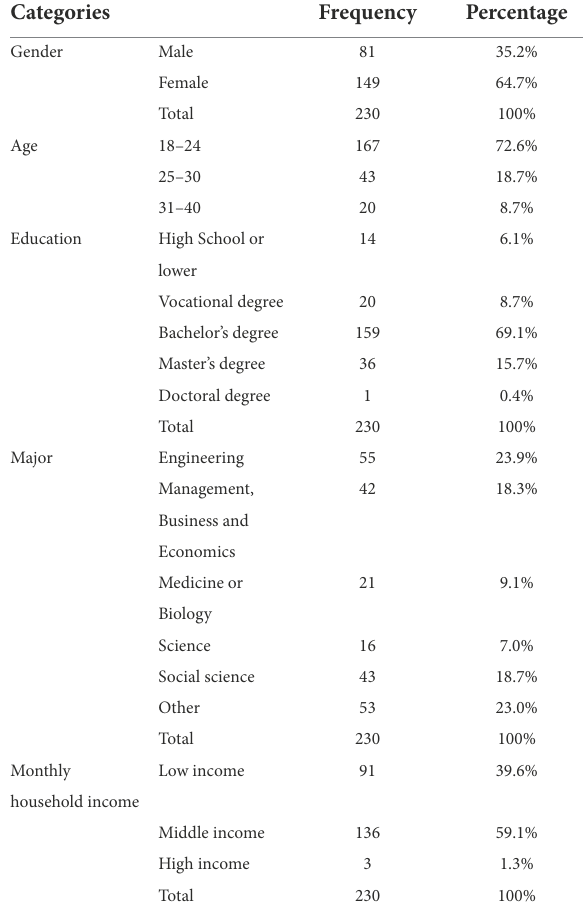
TABLE 3 Sample description of respondents ( n =